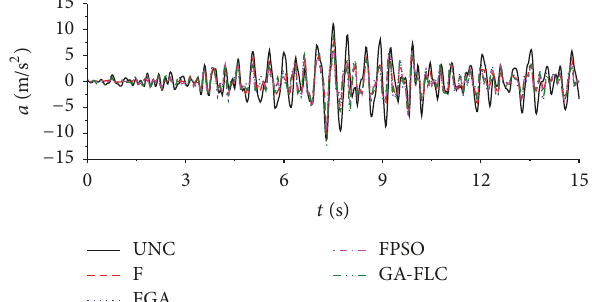
Figure 19: Top-layer acceleration response curve under the action of the Taft